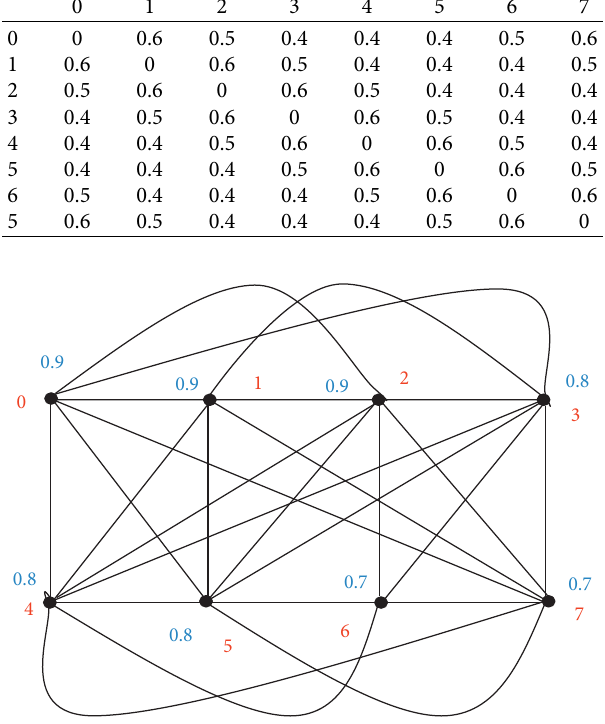
Figure 7: Te CFG for the matches of 8 teams in the country’s premier league.